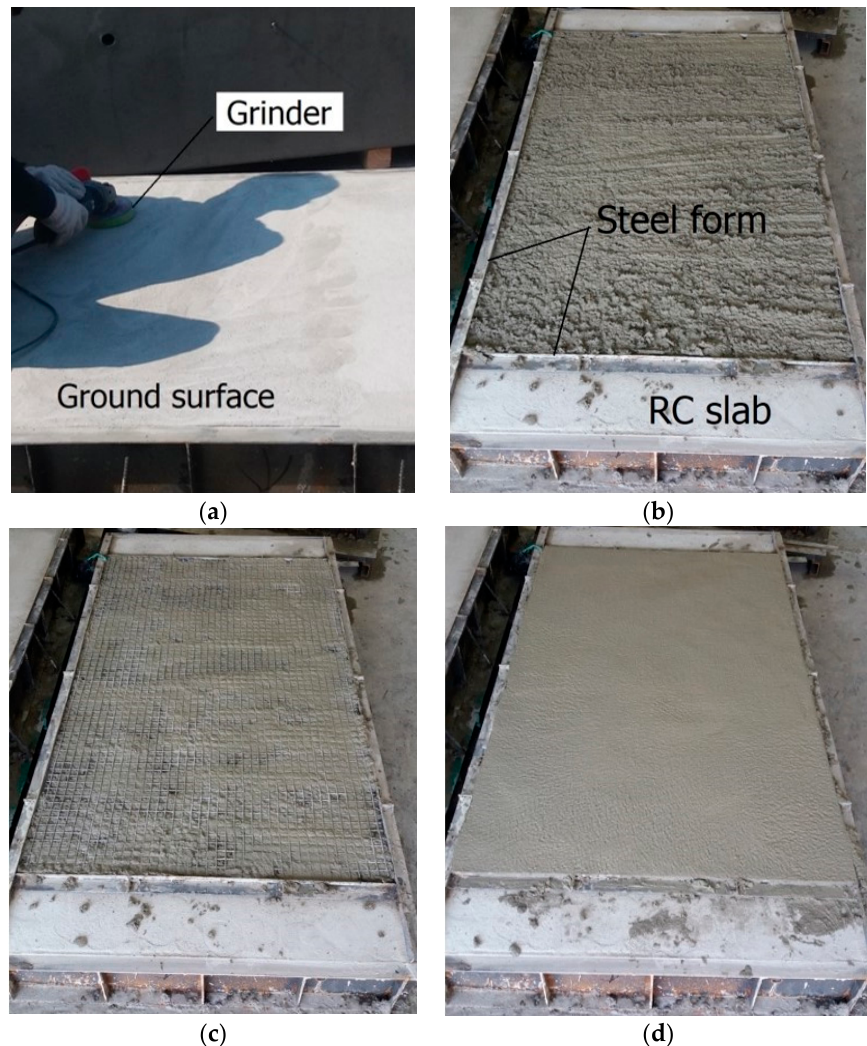
Figure 5. Fabrication process of the slab specimen. ( a ) Grinding of top surface; ( b ) Placing of 1st mortar layer; ( c ) Placing textile reinforcement; and ( d ) Placing of 2nd mortar layer.